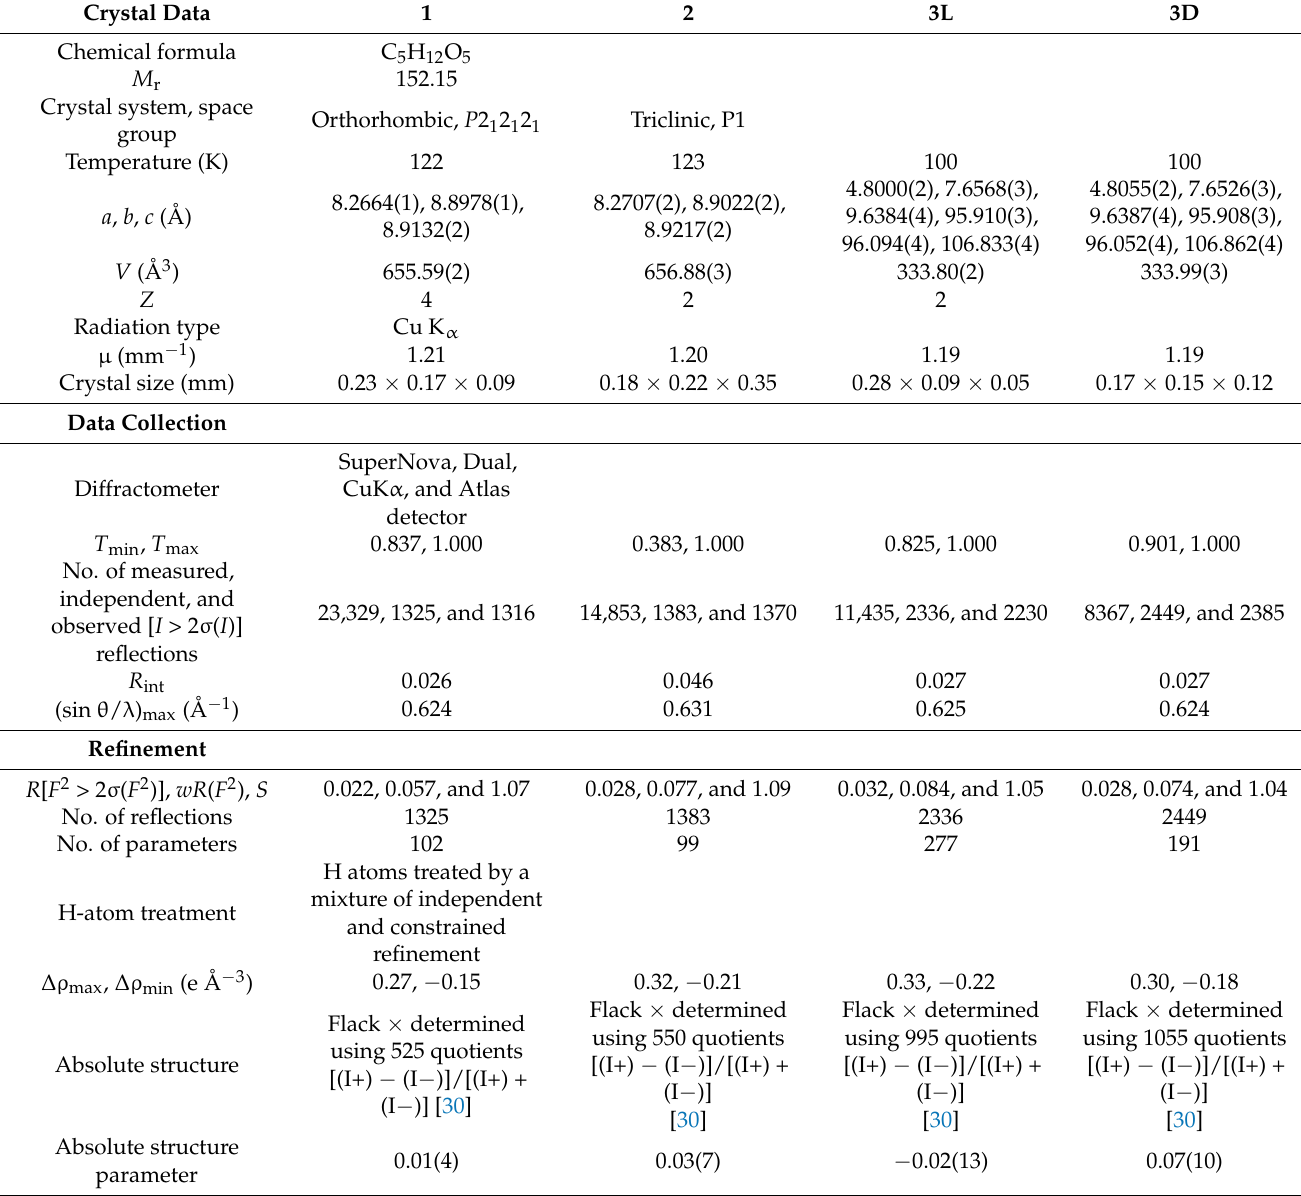
Table 3. Crystal data and experimental